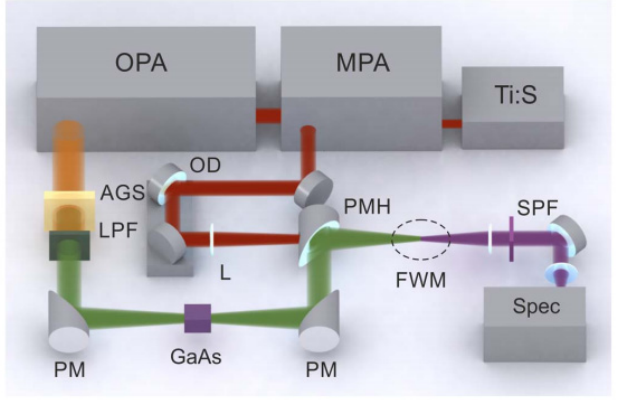
Figure 21. Experimental setup. Ti:S, mode-locked Ti:sapphire master oscillator; MPA, multipass amplifier; OPA, optical parametric amplifier; AGS, AgGaS 2 crystal; LPF, longpass filter; PM, parabolic mirror; L, BK7 glass lens; OD, optical delay line; PMH, parabolic mirror with a hole; FWM, four- wave mixing in a gas medium; SPF, shortpass filter; Spec, spectrometer. Reprinted with permission from [68].